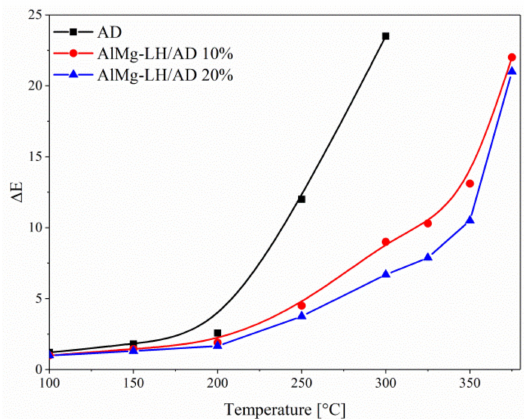
Figure 10. Color difference ( ∆ E) values for AD, AlMg − LH/AD 10%, and AlMg − LH/AD 20% powders during temperature